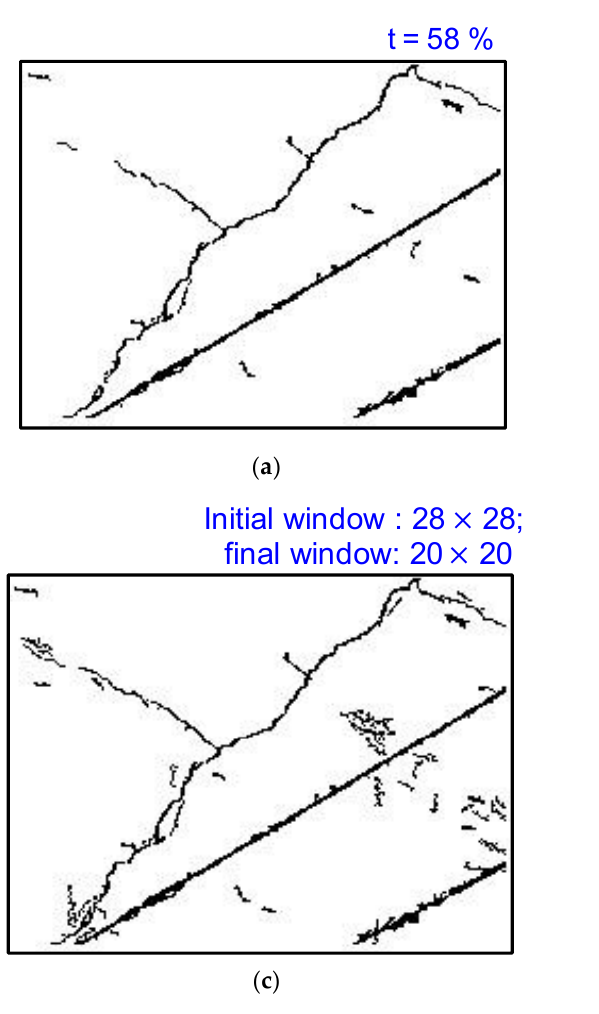
Figure 9. (a) Crack feature identification using 1D DL model with an initial sensitivity factor t = 58 % during image preprocessing. Effect of initial window size ( b ) 23 × 23, ( c ) 28 × 28, and ( d ) 35 × 35 on tracking thin shallow cracks. The software and compu-